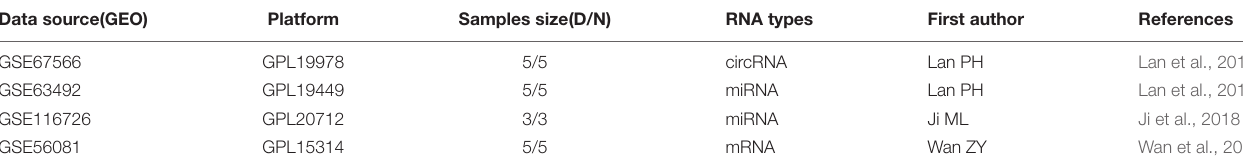
TABLE 1 | Basic information of the microarray